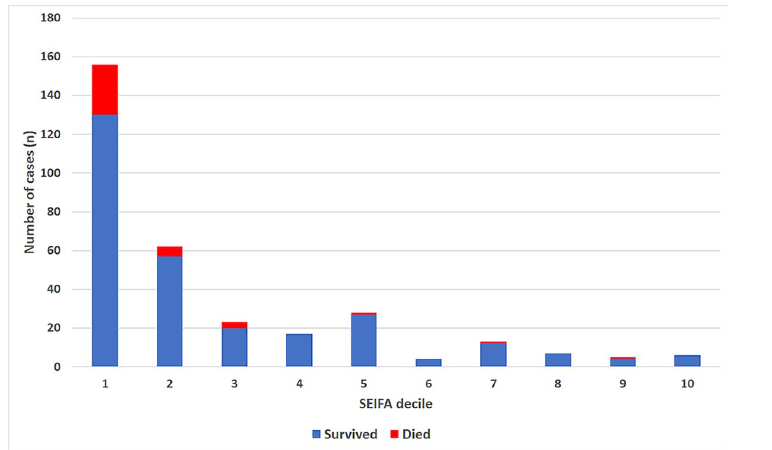
Fig 3. Case-fatality rate in the cohort stratified by SEIFA